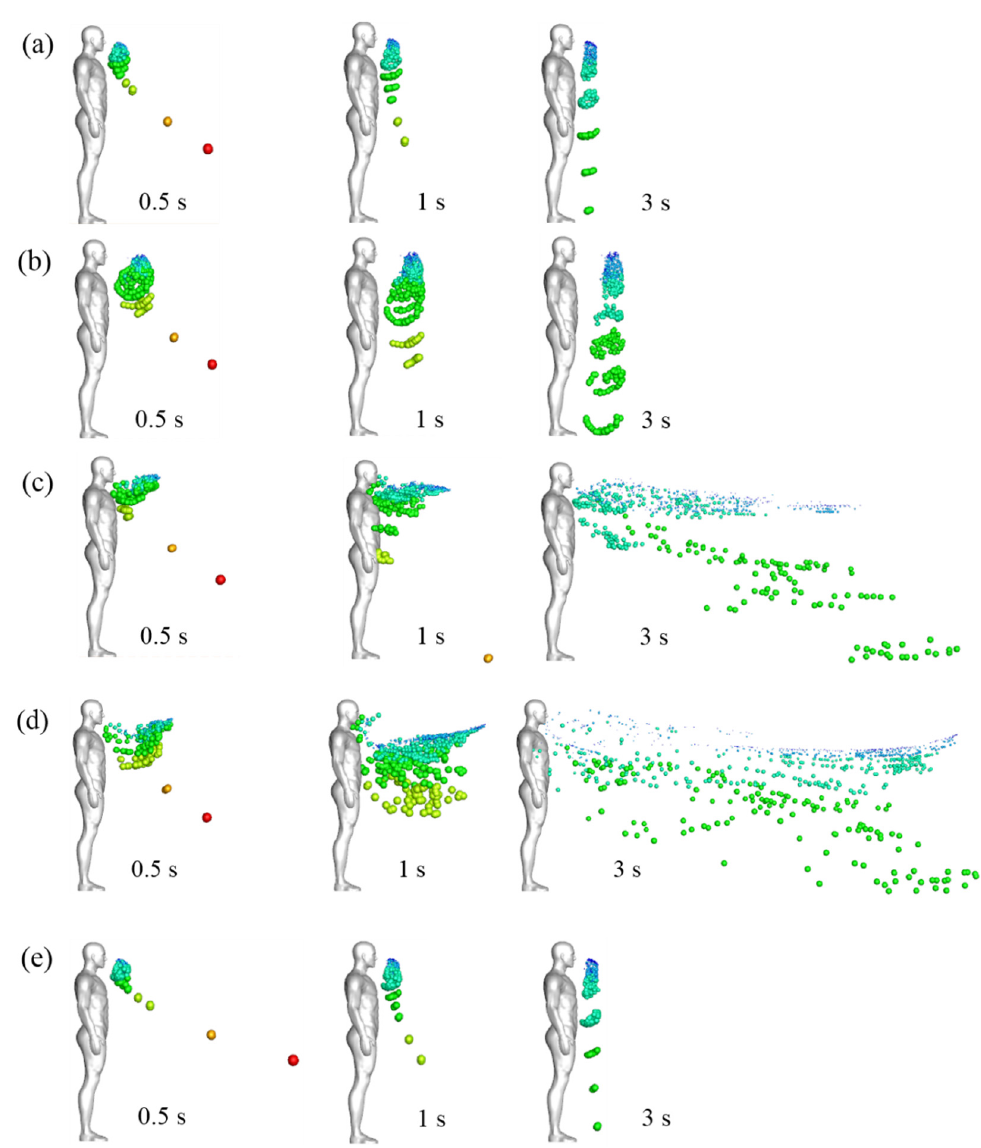
Figure 8. Droplet dispersions at different times in different wind environments: ( a ) Case 1 (no wind, standard cough jet, V P = 2.9 m/s); ( b ) Case 2 (no wind, double-strength cough jet, V P = 2.9 m/s); ( c ) Case 3 ( V in = 1.8 m/s, standard cough jet, V P = 2.9 m/s); ( d ) Case 4 ( V in = 1.8 m/s, double-strength cough jet, V P = 2.9 m/s); ( e ) Case 5 (no wind, standard cough jet, V P = 6 m/s).